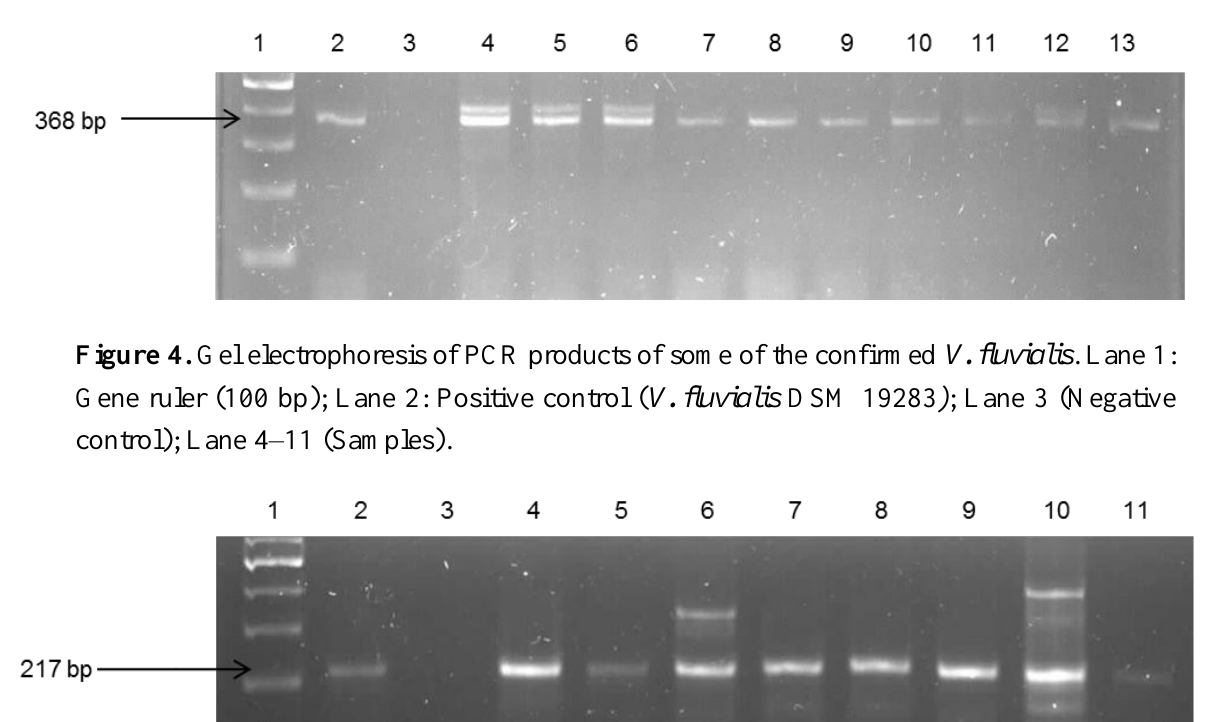
Figure 3. Gel electrophoresis of PCR products of some of the confirmed V. parahaemolyticus. Lane 1: Gene ruler (100 bp); Lane 2: Positive control ( V. parahaemolyticus DSM 11058 ) ; Lane 3 (Negative control); Lane 4–13 (Samples).